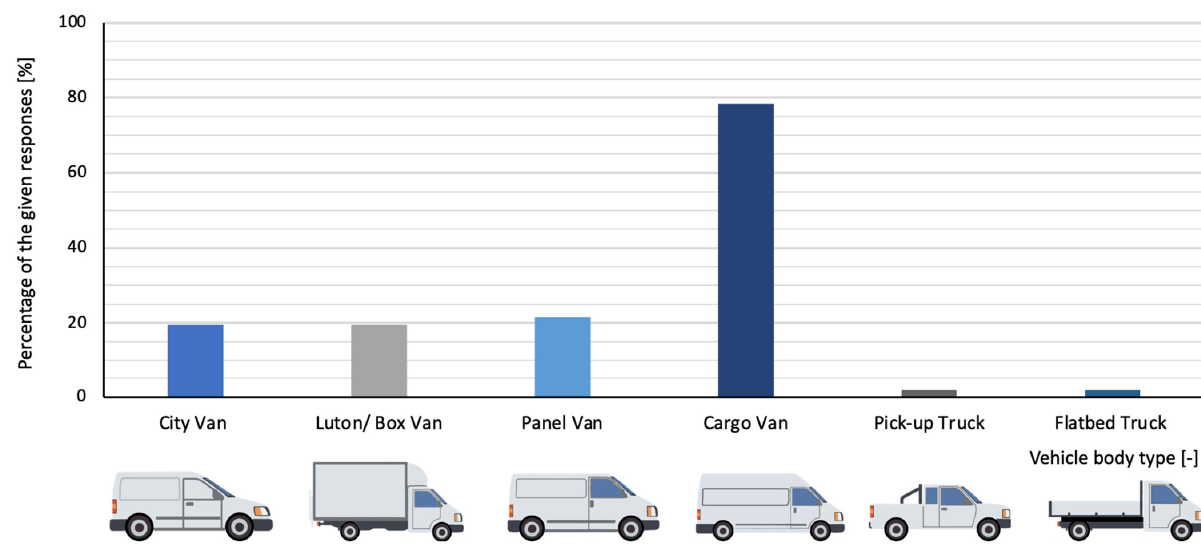
Figure 3. Type of light-duty vehicle used in the company (based on own survey).